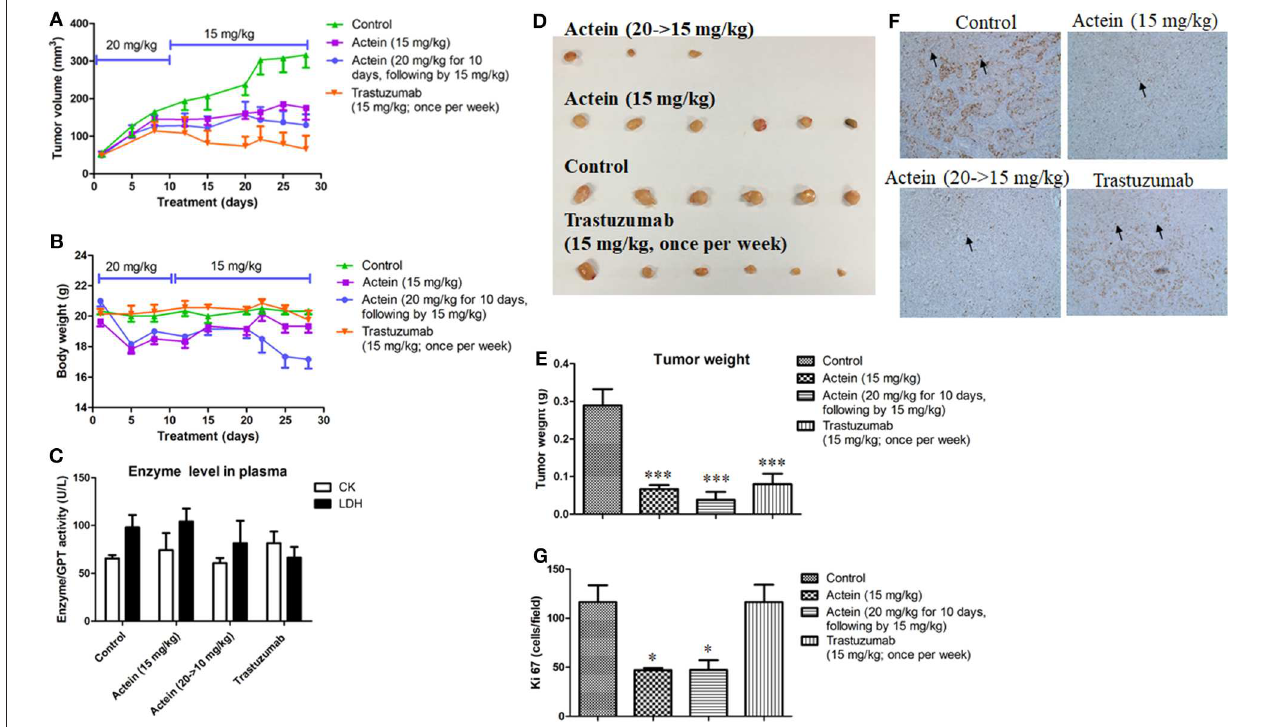
FIGURE 6 | Anti-tumor effect of actein on MDA-MB-361 tumor-bearing mice. Mice were i.p. administered with actein or trastuzumab or vehicle for 4 weeks. The volumes of (A) tumors and (B) body weights were recorded and expressed as mean ± SEM ( n = 12). (C) Plasma enzymes activities of LDH and CK were calculated at the end of the experiment. (D) The photos of tumors excised from mice of different treatment groups at the end of experiment. (E) Tumor weights were measured and expressed as mean + SEM. (F) Tumor tissues were examined by IHC staining with antibodies against Ki67 (brown staining). (G) Results showed the percentages of the Ki67 positive cells in the total number of cells per section. Each value was presented as means + SD ( n = 4). * p < 0.05, *** p < 0.001, compared with control using One-way